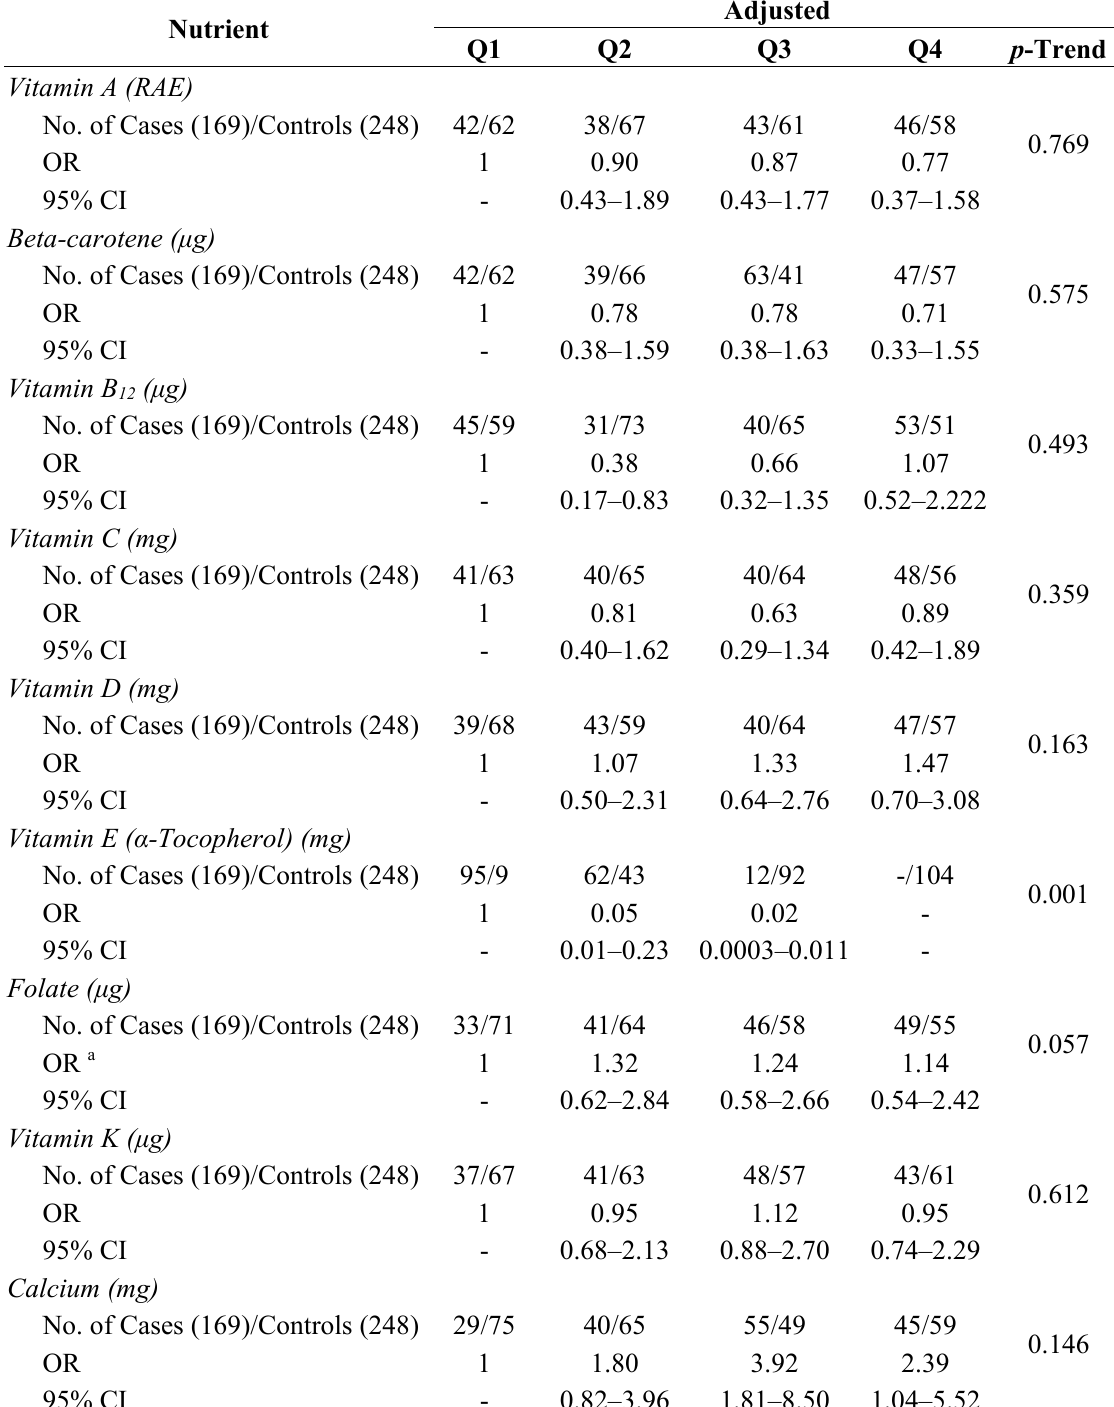
Table 4. Adjusted ORs a and CIs of CRC risk by micronutrient intake